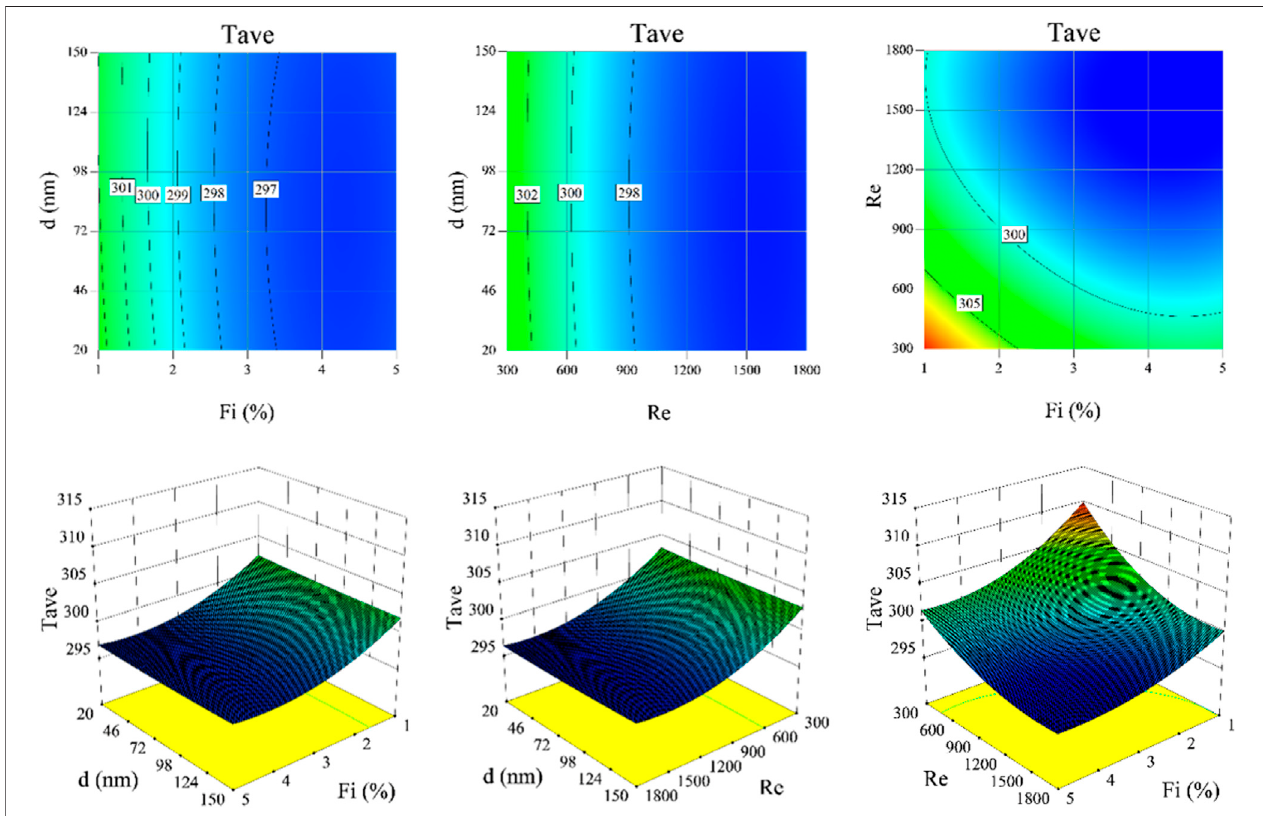
FIGURE 5 | Average temperature of the bottom of the H-S for variations of Re, d, and